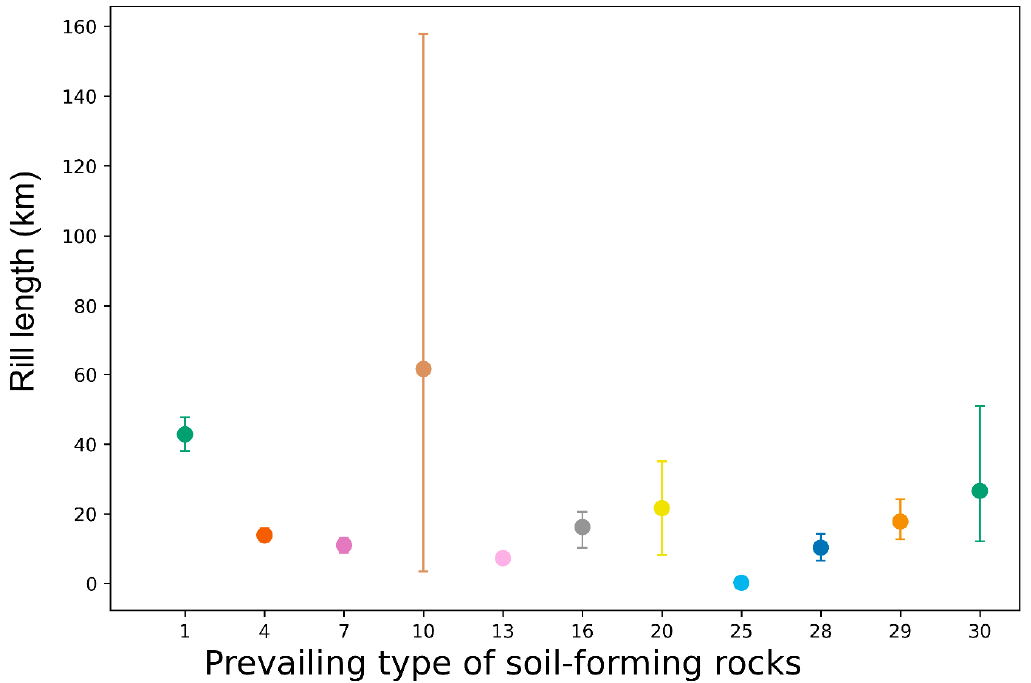
Figure 18. Dependence of the length of the erosion network on the prevailing type of soil-forming rocks. The rock types are given in the Supplementary Materials.